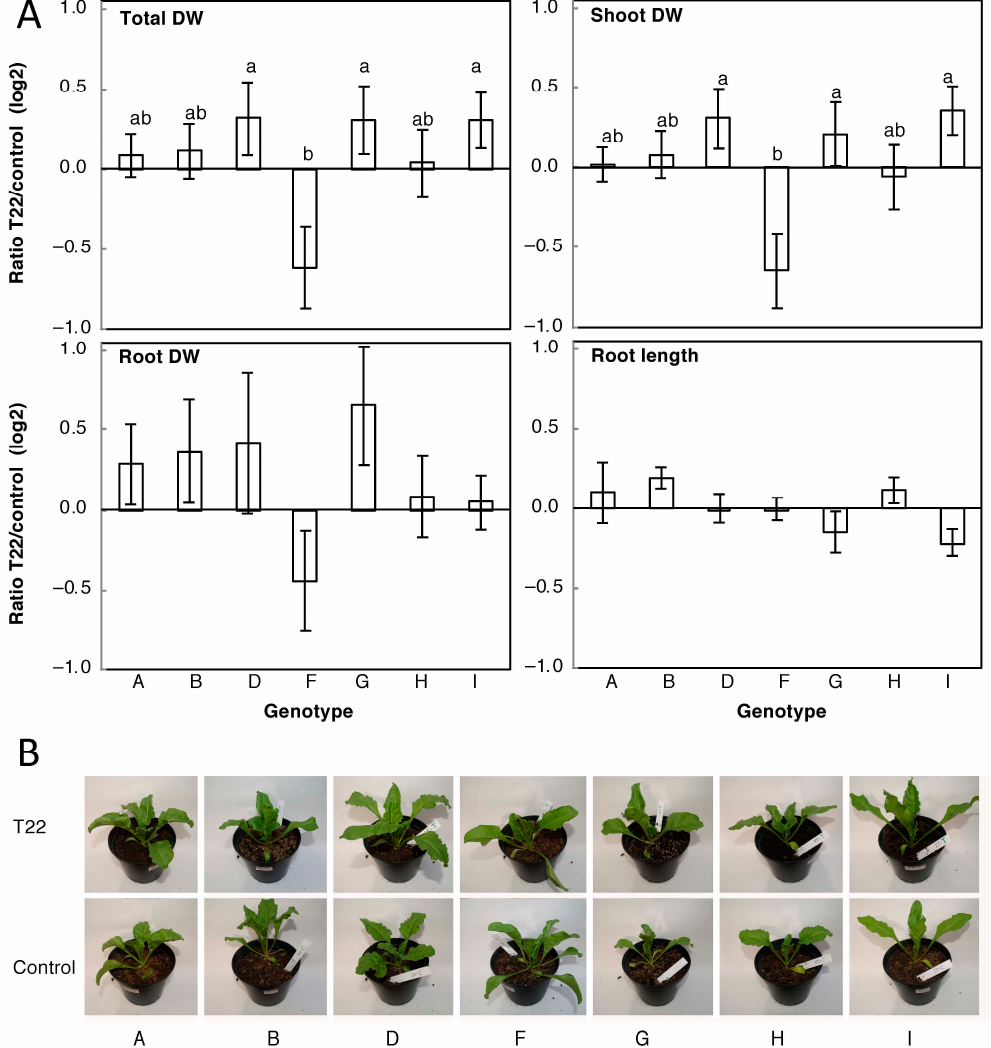
Figure 1. Effect of T22 on the growth of inbred sugar beet genotypes in soil. Twenty-day-old plants were treated with T22 or water, and grown in parallel for 2 or 3 weeks in two separate experiments. ( A ) shows the average effect of T22 ± SE ( n = 9–12 plants) for both experiments pooled. The average total fresh weight and dry weight (DW) at harvest were 9.0 ± 0.4 and 0.71 ± 0.03 g, respectively. Significant differences are denoted by different letters. In ( B ), representative plants from selected lines 2 weeks after treatment are shown.